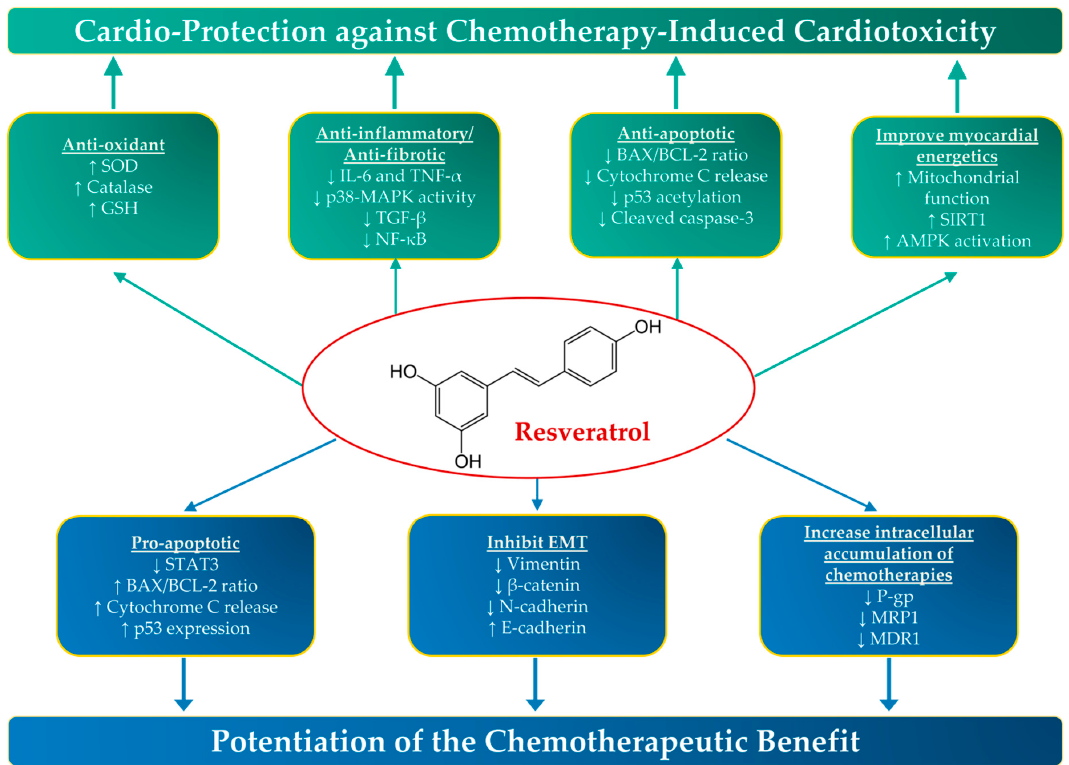
Figure 1. The cardio-protective and anticancer properties of resveratrol. Resveratrol has been shown to possess both cardio-protective and anticancer properties in preclinical studies through a number of molecular mechanisms. AMPK, Adenosine Monophosphate-Activated Protein Kinase; Bax, BCL (B Cell Lymphoma)-Associated X; EMT, Epithelial Mesenchymal Transition; GSH, Glutathione; IL-6, Interleukin-6; MAPK, Mitogen-activated protein kinase; MDR1, Multidrug Resistance-1; MRP1, Multidrug resistance-associated protein-1; NF- κ B, nuclear factor kappa B; P-gp, P-glycoprotein; STAT3, Signal transducer and activator of transcription 3; SIRT1, Sirtuin 1; SOD, Superoxide Dismutase; TNF- α , Tumor Necrosis Factor-alpha; ↑ , increase; and ↓ , decrease.